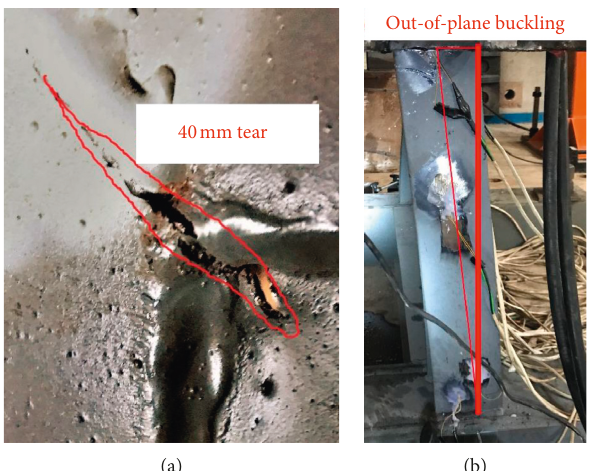
Figure 7: Damage to the end of the test of specimen C. (a) Tear at the upper left corner and (b) the failure mode.